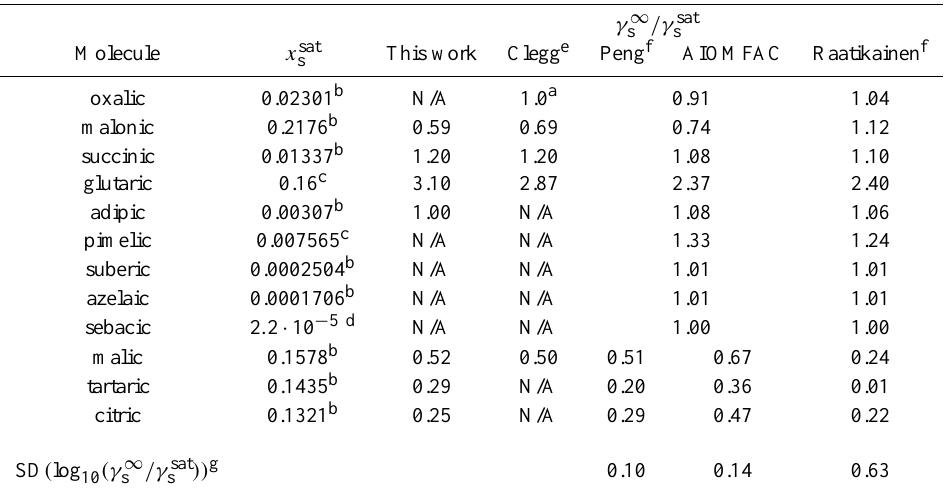
Table 2. x sat s and γ ∞ s /γ sat s data at 25 ◦ C. See Appendix A for the derivation and the used experimental a w data. Note that for the linear diacids, UNIFAC-Peng and AIOMFAC return identical